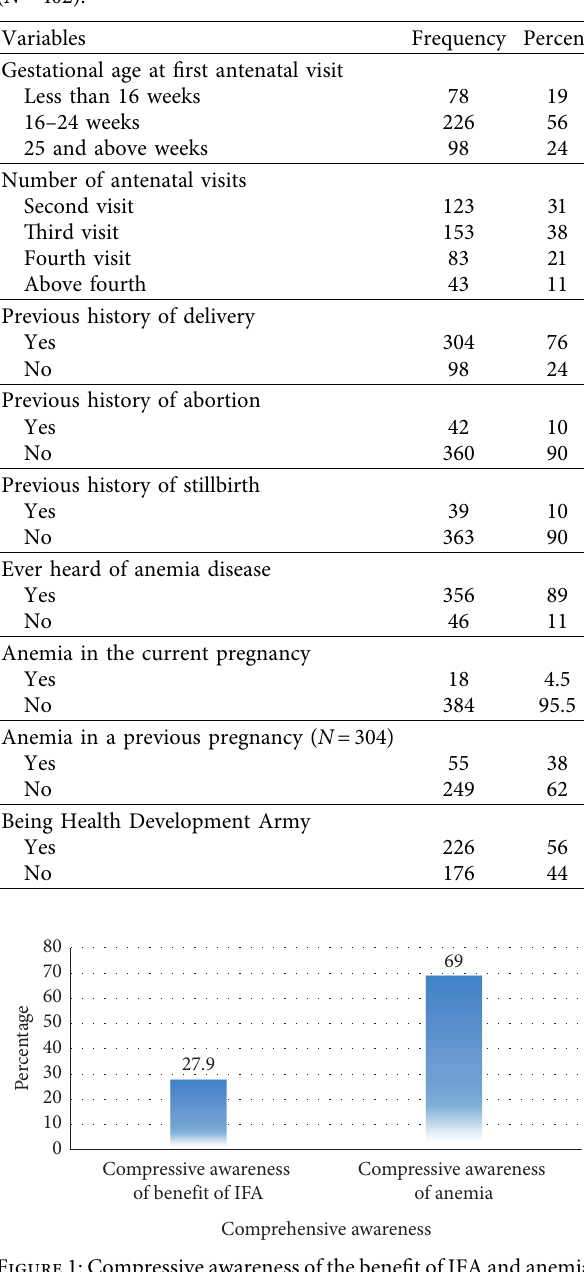
Table 1: Sociodemographic characteristics of pregnant women attending antenatal care and taking iron-folate, Shalla district health facilities, West Arsi Zone, Southwest Ethiopia, 2019